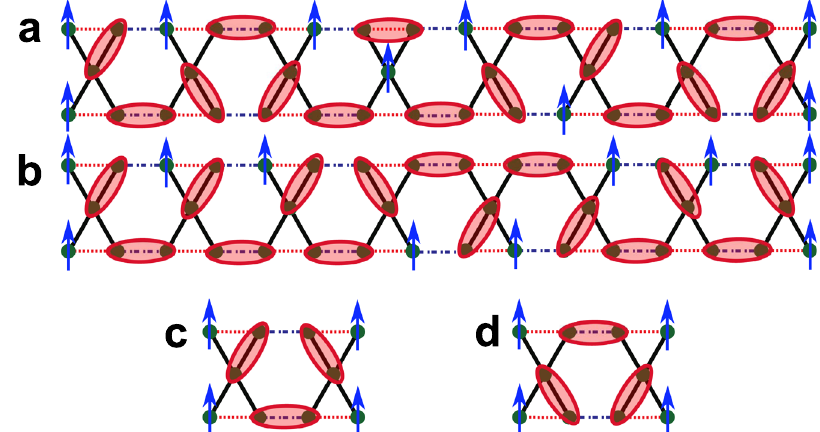
Fig. 8 Schematic diagrams of the dimer – monomer states. Two dimer – monomer states for ( a and b ) L = 8 and ( c and d ) L = 2 under the open boundary condition at M / M sat = 1/5 + 2/ N , where L is the number of the 5-site unit, M is the magnetization, and M sat is the saturation magnetization. The green circles denote the sites with spin. The monomers are depicted as blue arrows, whereas the dimers are represented as red ellipses containing two sites. Note that all 5-site units except at both ends in a and b have only one monomer, and there is no nearest-neighboring monomer. The monomers at both ends correspond to the edge